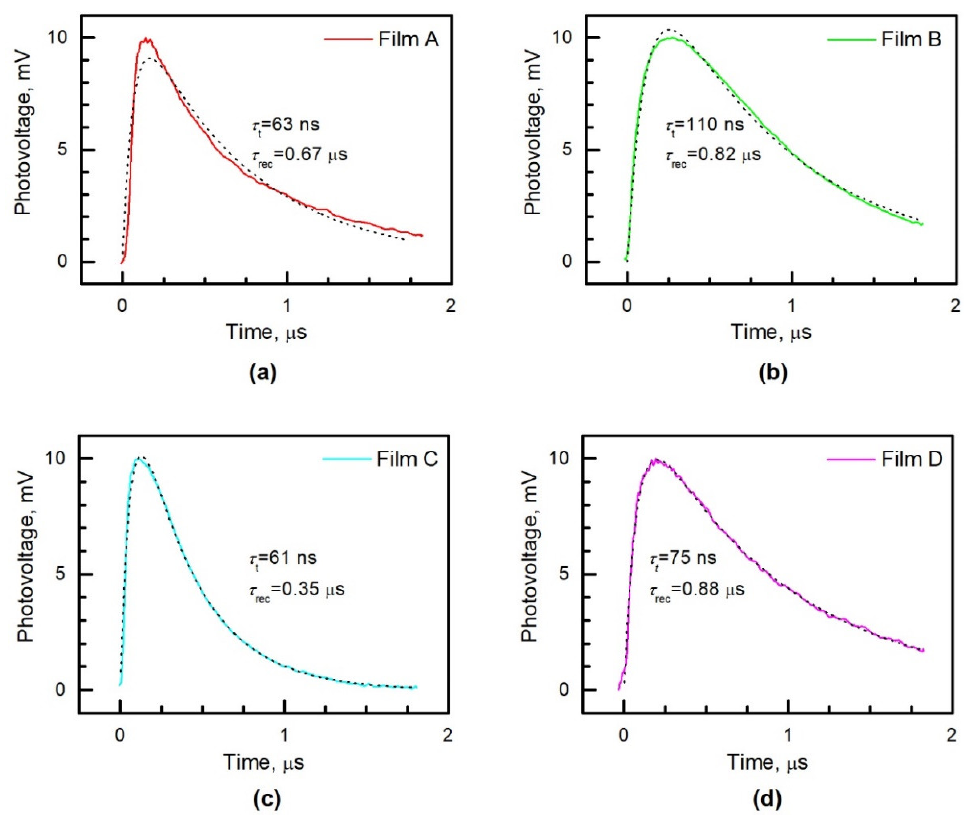
Figure 9. Photovoltage decay transients of the solar cells fabricated on the base of different perovskite films: ( a ) Film A, ( b ) Film B, ( c ) Film C, ( d ) Film D. Black dotted lines indicate fitting according to Equation (3), and τ t and τ rec are the electron transport and recombination time constants, respectively.